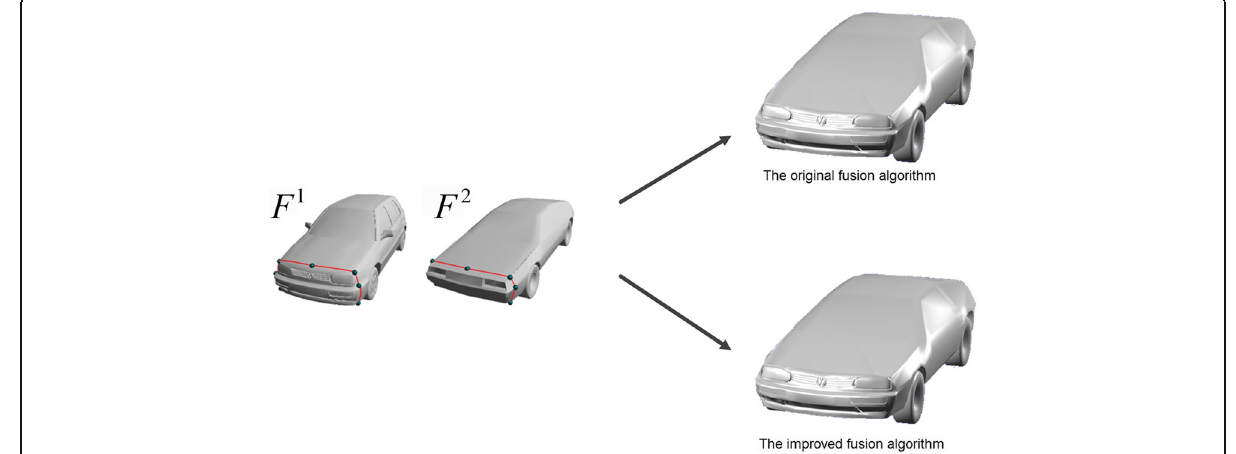
Fig. 12 Comparison of different fusion results